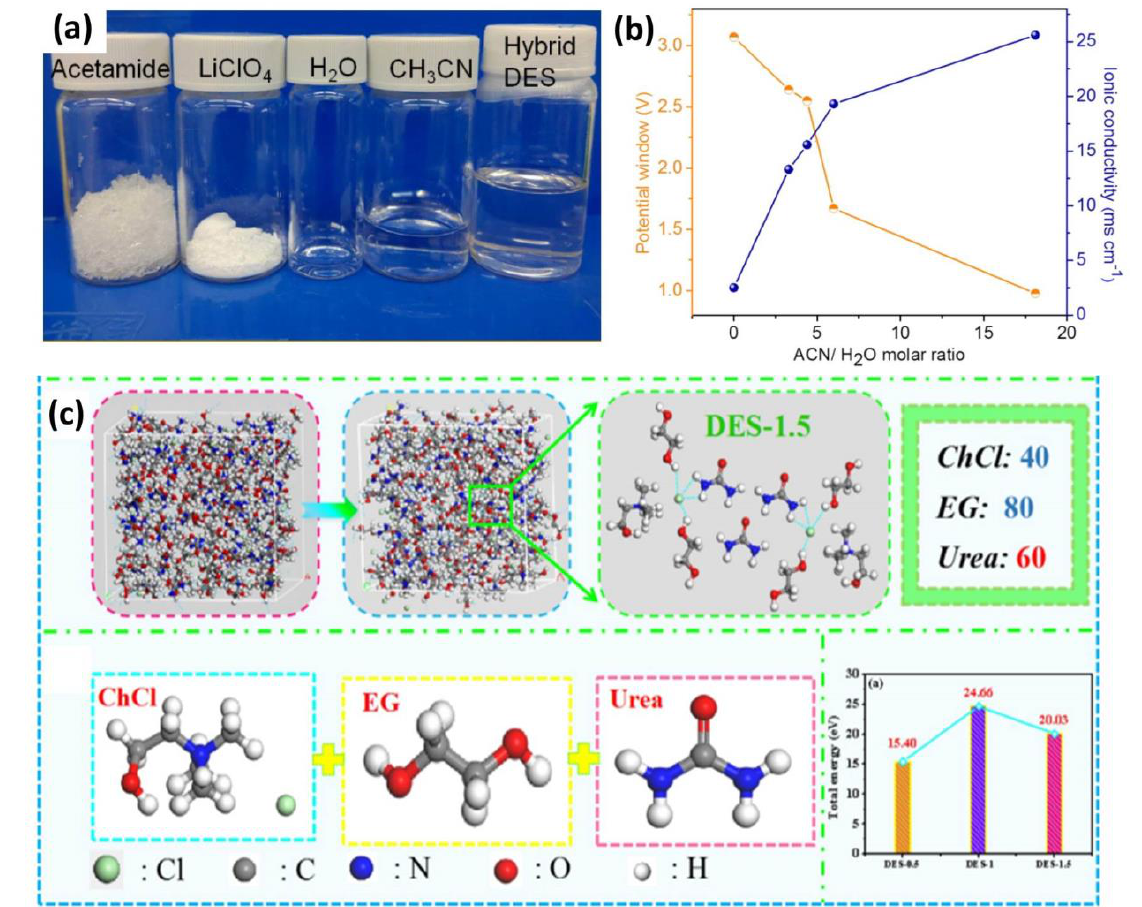
Figure 4. ( a ) Photograph of the corresponding components of a hybrid DES. ( b ) A plot illustrating the changes in ionic conductivity of DES electrolytes with varying molar ratios of acetonitrile/water mixtures. Reprinted with the permission of [90]. ( c ) MD simulation of a DES system prepared from the ternary mixture of choline chloride, ethylene glycol, and urea. Reprinted with the permission of [91].